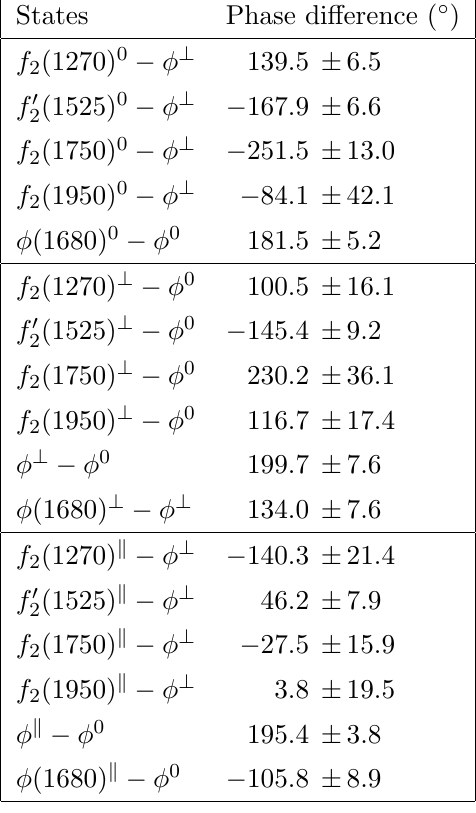
(cid:12)t model. The (cid:12)t model uncertainties are determined by doubling the number of S-wave 1 : 5 GeV (cid:0) 1 for K + K (cid:0) resonances and 5 : 0 GeV (cid:0) 1 for the B 0